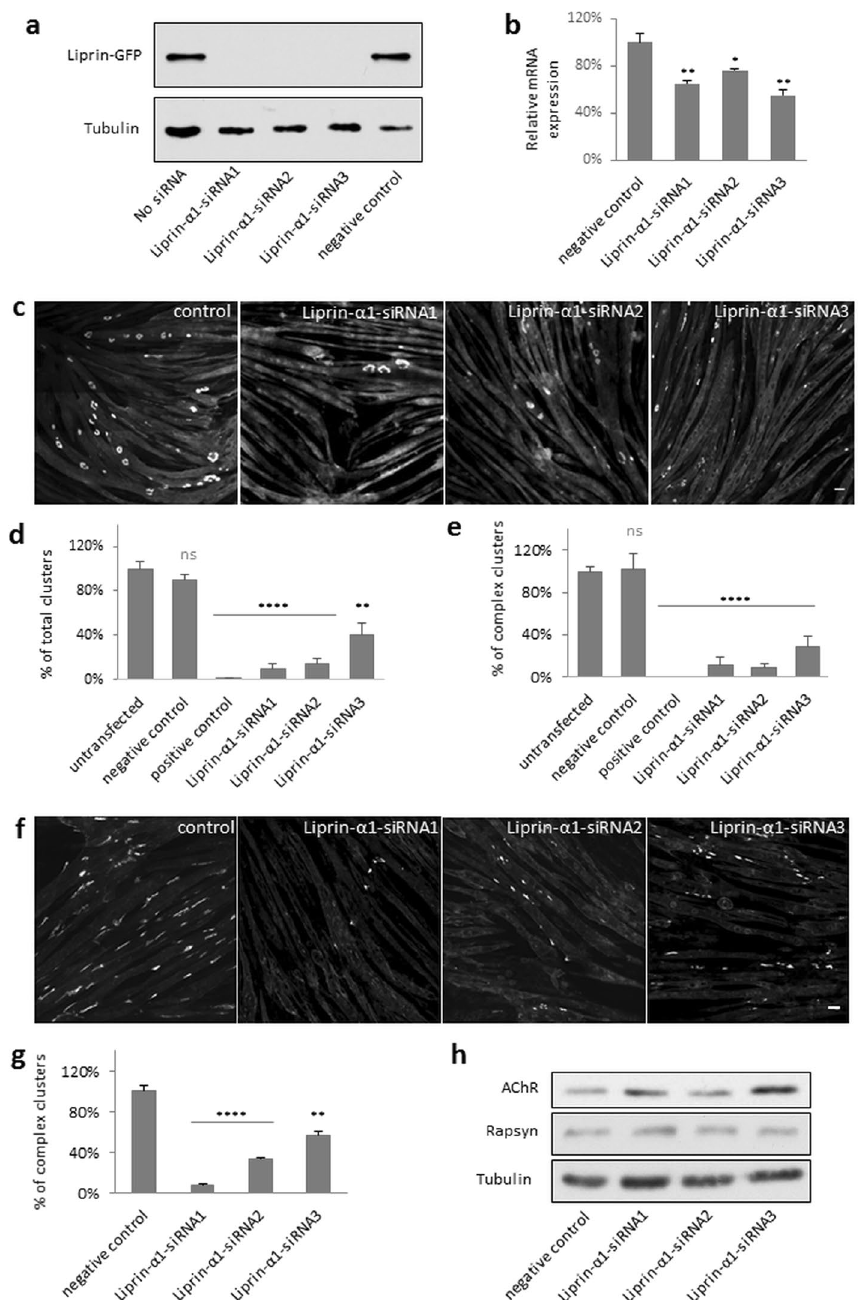
Figure 4. Liprin- α -1 is required for the formation of AChR clusters. ( a ) Validation of liprin- α -1 knockdown efficiency by Western blot. Hek-293 cells were co-transfected with liprin- α -1-GFP and the indicated siRNAs that targeted liprin- α -1 or indicated control siRNAs. Western blot for tubulin was used as a loading control. ( b ) Validation of liprin- α -1 knockdown efficiency by qRT-PCR. C2C12 differentiated myotubes were transfected with indicated siRNAs and 2 days later the total RNA was isolated from cell extract followed by qRT-PCR analysis of liprin- α -1 expression. ( c ) C2C12 myotubes cultured on laminin-coated surfaces were transfected with siRNAs that targeted liprin- α -1 and AChR clusters were visualised with BTX. ( d ) Quantification of the total number of clusters. ( e ) Quantification of topologically complex (perforated) clusters. ( f , g ) Liprin- α -1 was essential for the formation of agrin-induced AChR clusters. C2C12 myotubes were cultured on gelatin-coated surfaces, transfected with siRNAs that targeted liprin- α -1, and stimulated with soluble agrin (Z-fragment) to form AChR clusters. ( g ) Quantification of AChR clusters in ( f ). ( h ) Western Blot analysis of AChR and rapsyn expression levels after liprin- α -1 knockdown. Lysates from C2C12 myotubes transfected with liprin- α -1 targeting siRNAs or non-targeting RNAs were probed with antibodies against specified proteins. Levels of tubulin were used as a loading control. Negative control -non-targeting siRNA; positive control - muscle-specific kinase (MuSK) siRNA. Statistical significance was analysed using 2-tailed t-test. * p < 0.05; ** p < 0.01; **** p < 0.0001. Error bars represent standard error of the mean (SEM). Scale bar 20 μ